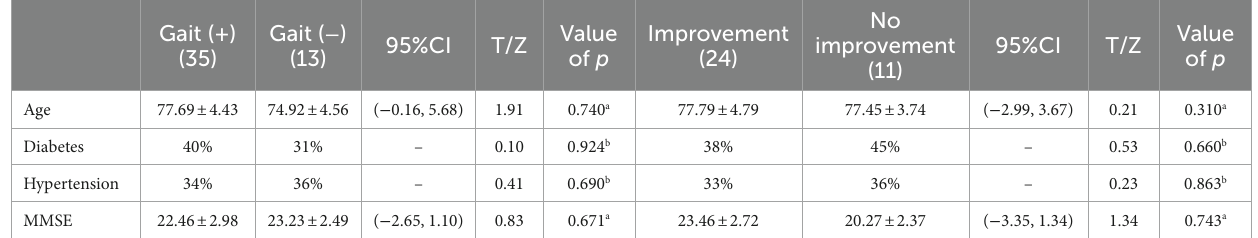
TABLE 3 Differences in baseline data between the two subgroups gait (+) versus gait ( − ) and improvement versus no improvement.